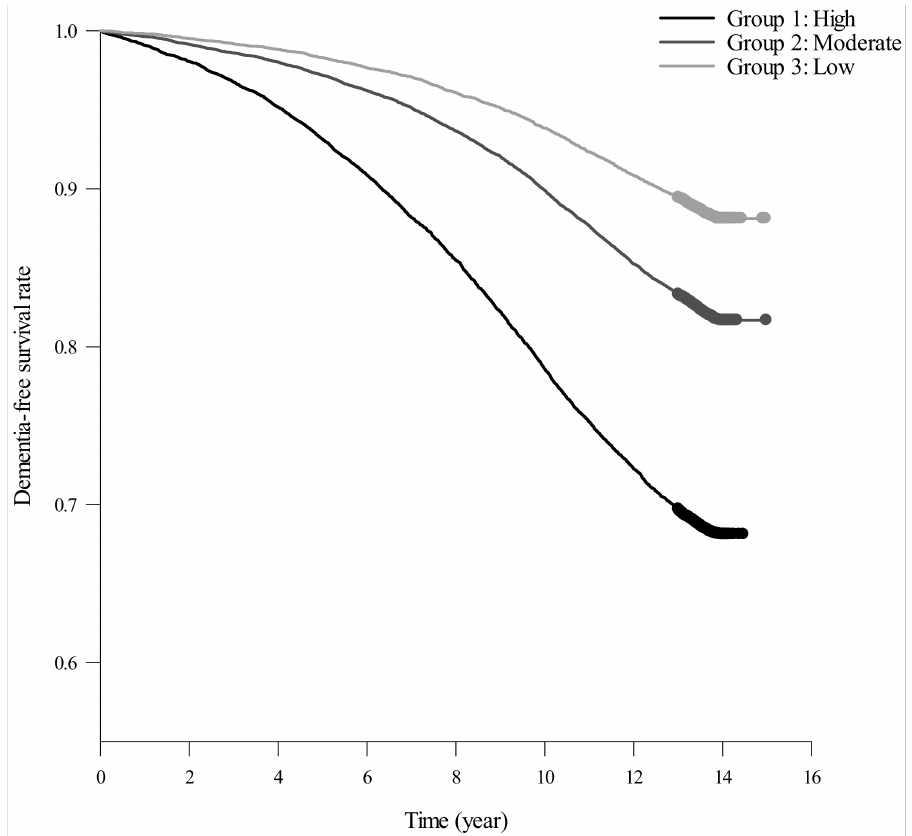
Figure 2. Dementia-free survival rate among three distinct trajectory groups in dementia incidence as estimated by Kaplan–Meier method (Log-rank test: p < 0.001; all pairwise comparisons: p <